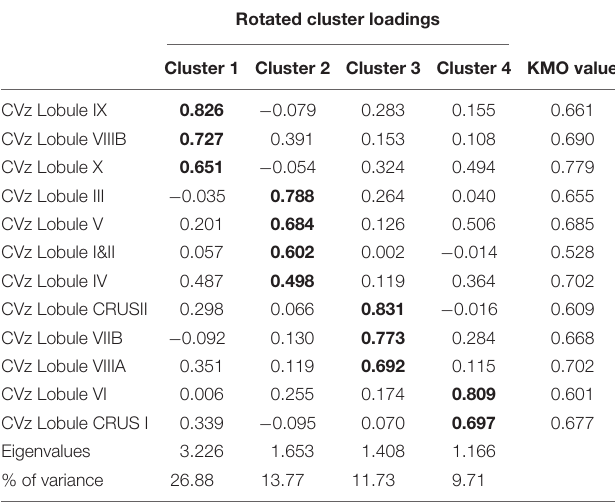
TABLE 3 | Pattern matrix of PCA results for cerebellar lobar values of Cortical Volumes (CV) of 94 subjects (66 patients with ALS and 24 HCs).